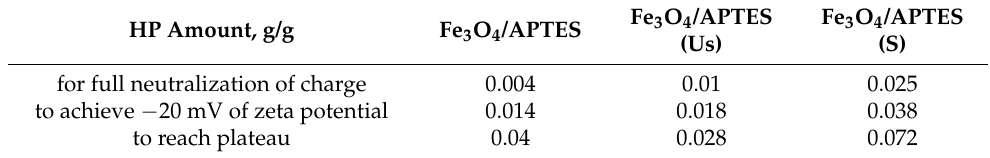
Table 3. Amount of HP needed to change the surface charging of the Fe 3 O 4 /APTES